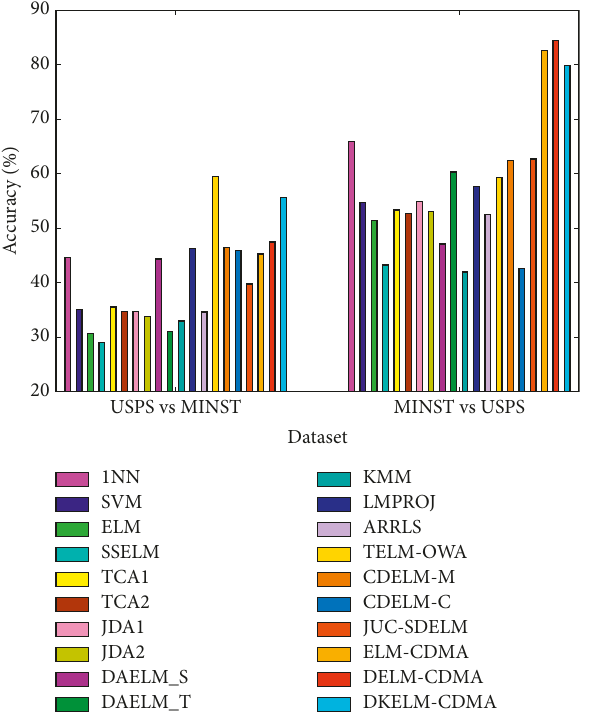
Figure 6: Classification accuracy of different algorithms on USPS +MNIST data set.